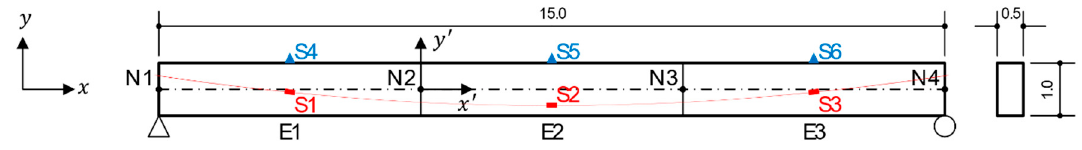
Figure 3. Structure shape and sensor layout of numerical example (unit: m).